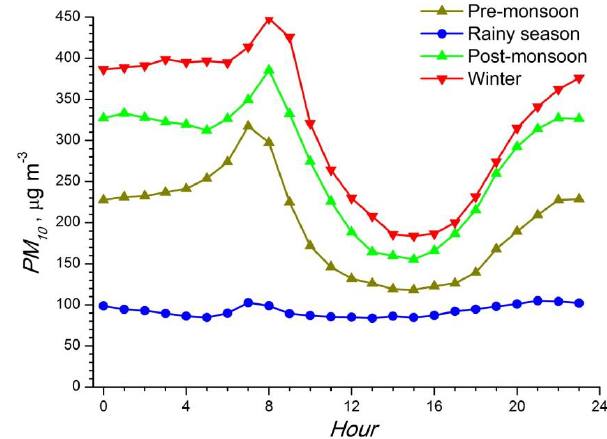
Fig. 4. Diurnal variation of the PM 10 mass during different seasons in the Indian EUCAARI